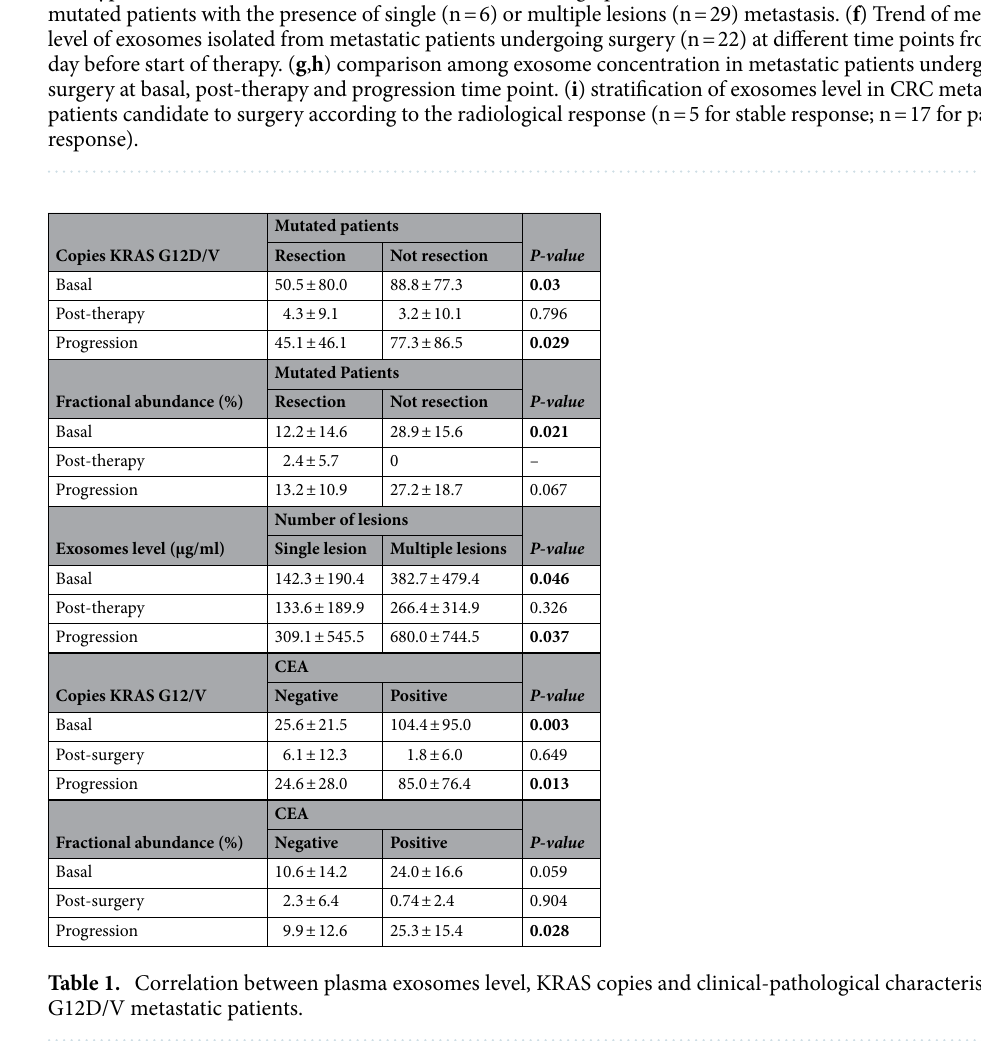
Table 1. Correlation between plasma exosomes level, KRAS copies and clinical-pathological characteristics in G12D/V metastatic patients.